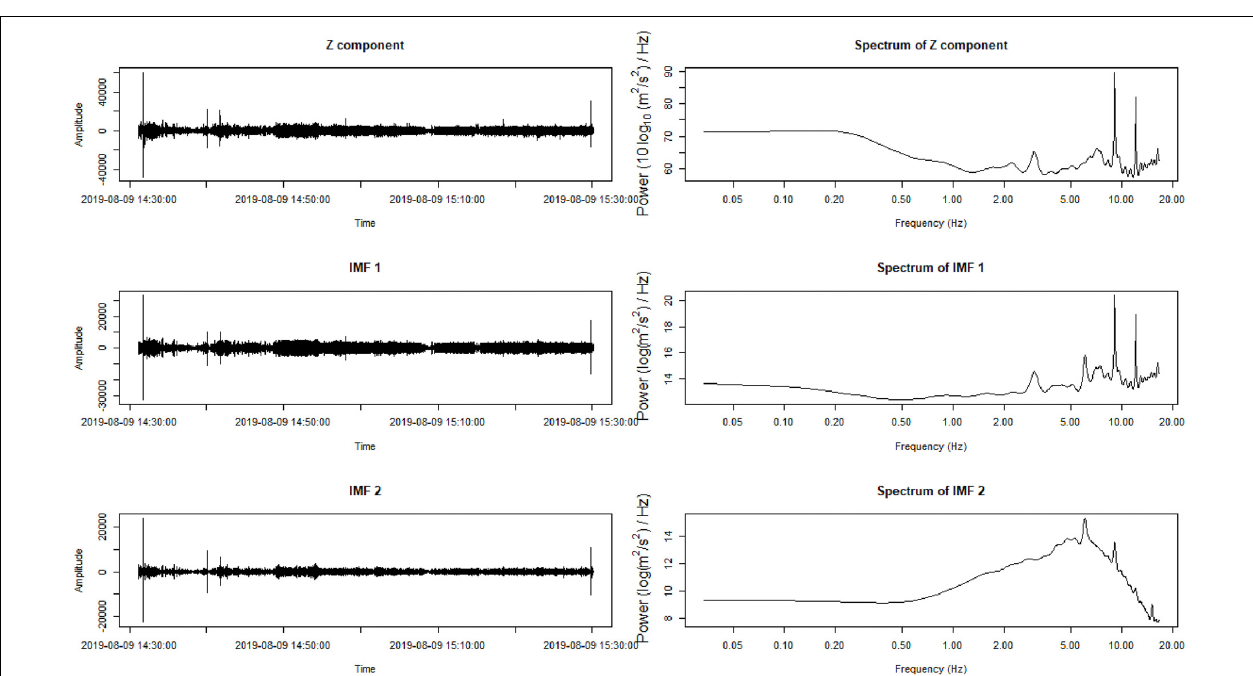
Frontiers in Earth Science |